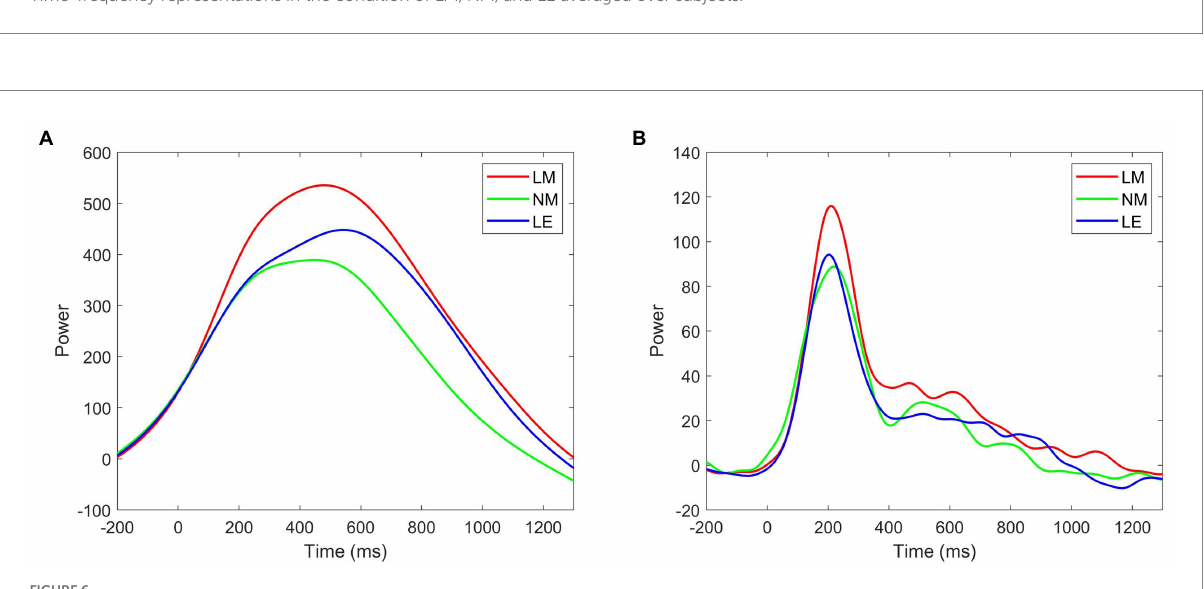
FIGURE 6 Temporal waveforms of power modulation. (A) delta; (B) theta.